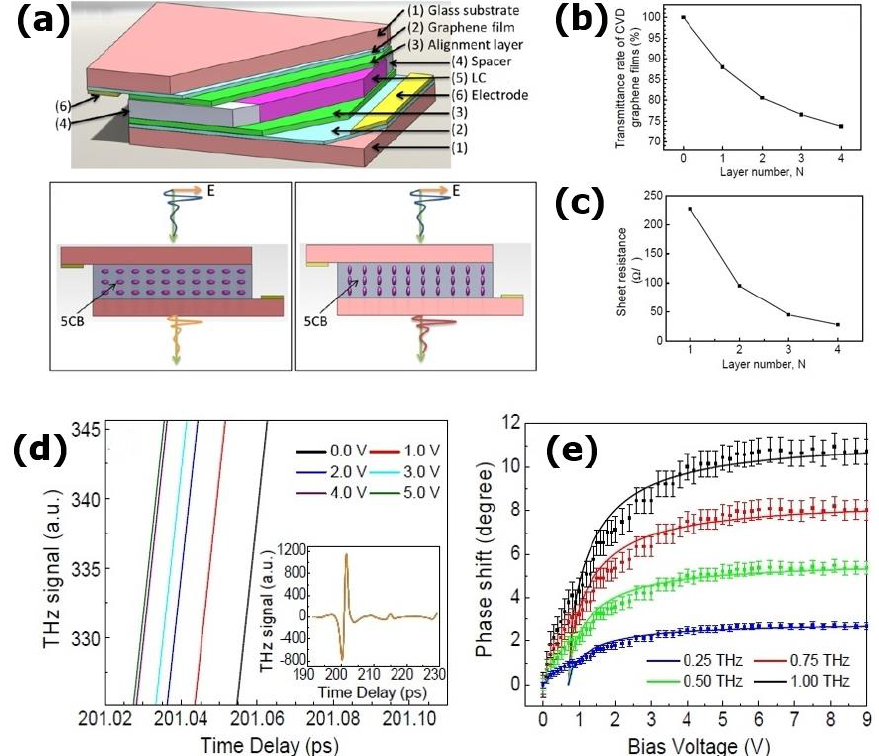
Figure 17. Liquid crystal THz wave shifter with graphene electrodes. ( a ) Schematic device with a glass substrate, graphene electrode, and alignment layer sandwich cell, confining the liquid crystal. The liquid crystal director is reoriented from planar (left) to homeotropic (right) on application of an electric field. ( b ) The transmittance of the device decreases with increasing graphene film thickness, while ( c ) the sheet resistance also decreases. ( d ) THz signal transmitted through the phase shifter device at varied applied electric voltages. ( e ) Phase shift as a function of applied bias voltage for several THz frequencies. (Reproduced by permission from [168]).